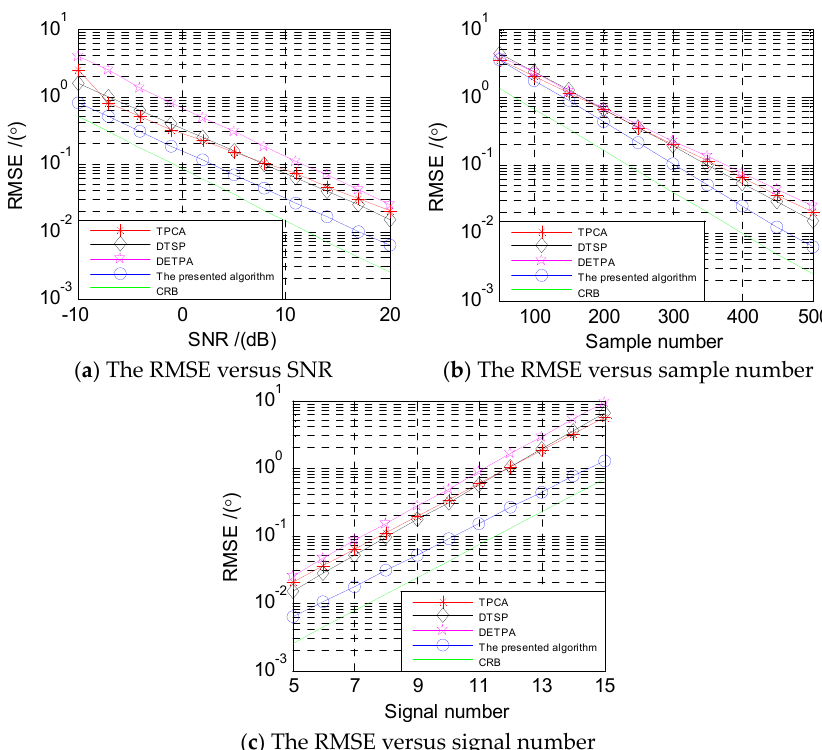
Figure 5. The algorithms’ performance comparison.